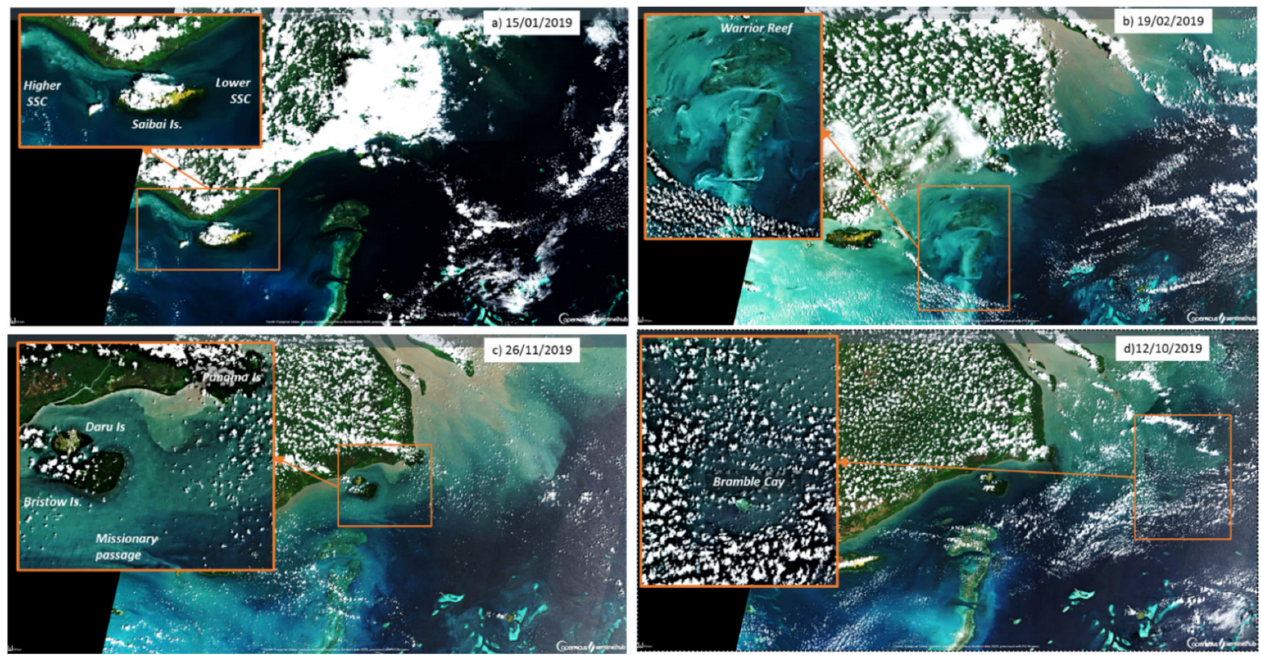
Figure 10. High resolution (10-m) S2 true colour images captured during the (top) monsoon and (bottom) trade wind seasons illustrating the very complex sediment circulation in the study area. ( a ) Typical monsoonal pattern with no sediment imports from the Fly River and higher SSC concen- trations west of Saibai Island. Conversely, ( b ) shows high turbidity levels all along the PNG coast and in the middle of TS and is a great illustration of flow channelisation in passages among the Warrior Reefs. Trade wind image ( c ) illustrates complex sediment transport patterns near the coast and Fly River sediments flowing westward through passages between Panama and Daru Island and the PNG coast and through Missionary Passage, ( d ) a large Fly River plume reaching Bramble Cay, 55 kilometres SE of the mouth of the Fly River. Images are from the Sentinel-hub website and have been enhanced by +40% (brightness and contrast). Enlargements have been sharpened by 50% (extracted from